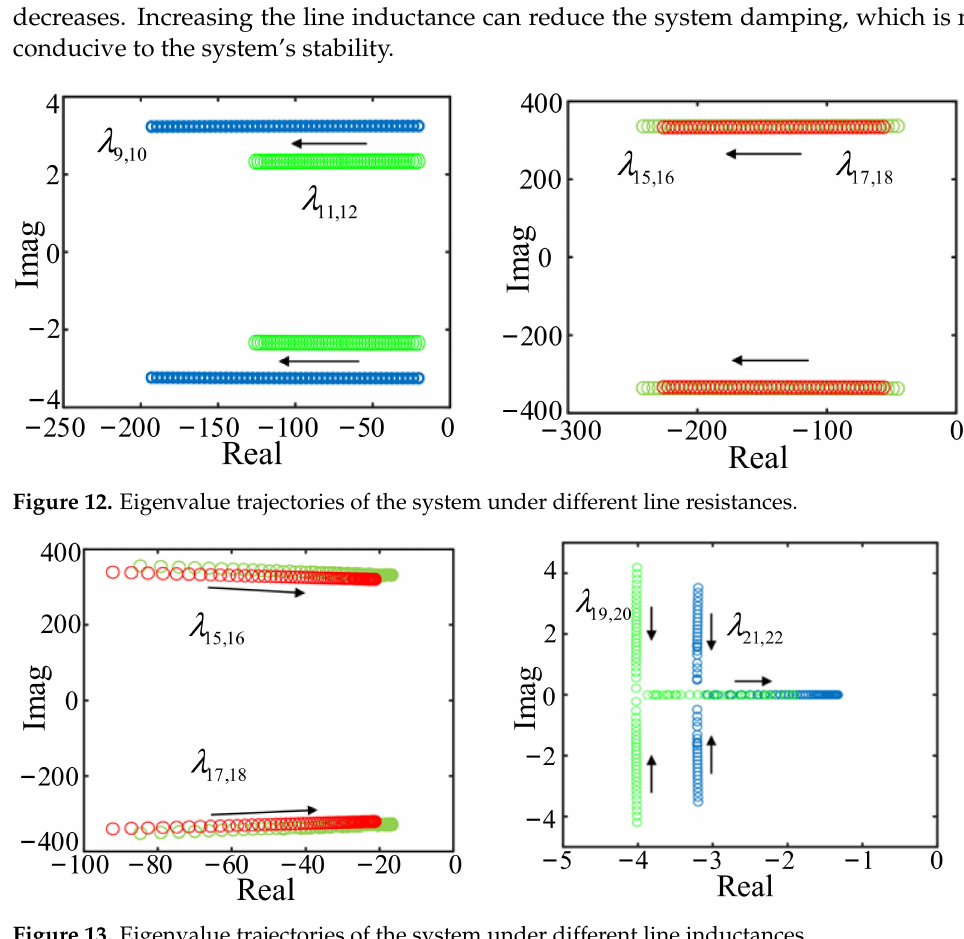
Figure 13. Eigenvalue trajectories of the system under different line